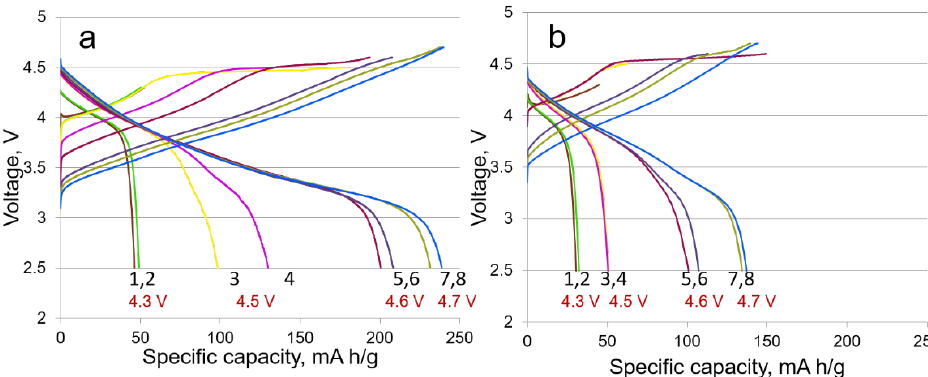
Figure 3. Charge – discharge curves of the formation cycles for LMR50 sample at the current densities of ( a ) 20 mA/g ( protocol 1 ) and ( b ) 80 mA/g ( protocol 2 ).